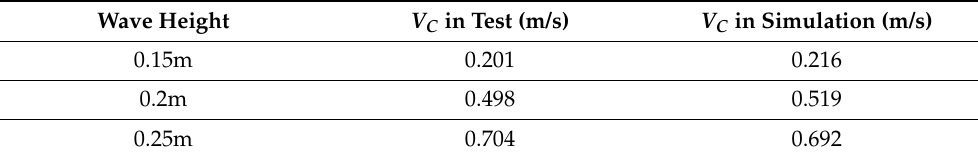
Figure 14. Self-propulsion test in towing tank. ( a ) Indoor positioning equipment. ( b ) Top view of test in towing tank. ( c ) Side view of test in towing tank. Table 12. Average values of V C in test and simulation (Wavelength is 8